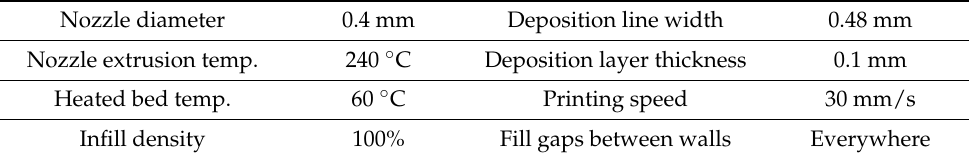
Table 4. Fixed printing parameters.